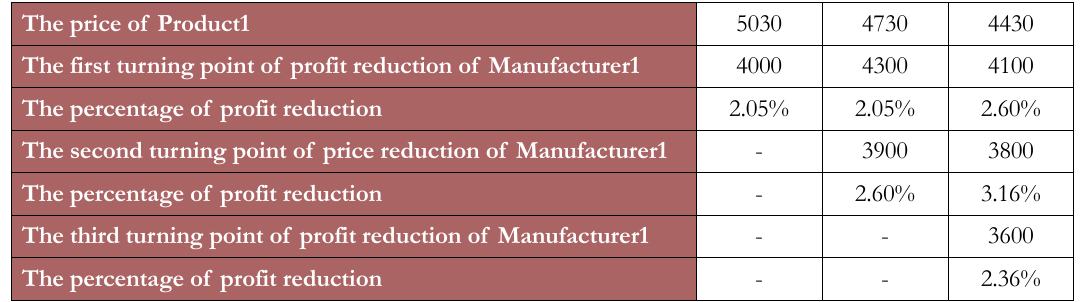
Table 5. The situation of Manufacturer1’s profit change with the Lenovo and HP computer prices